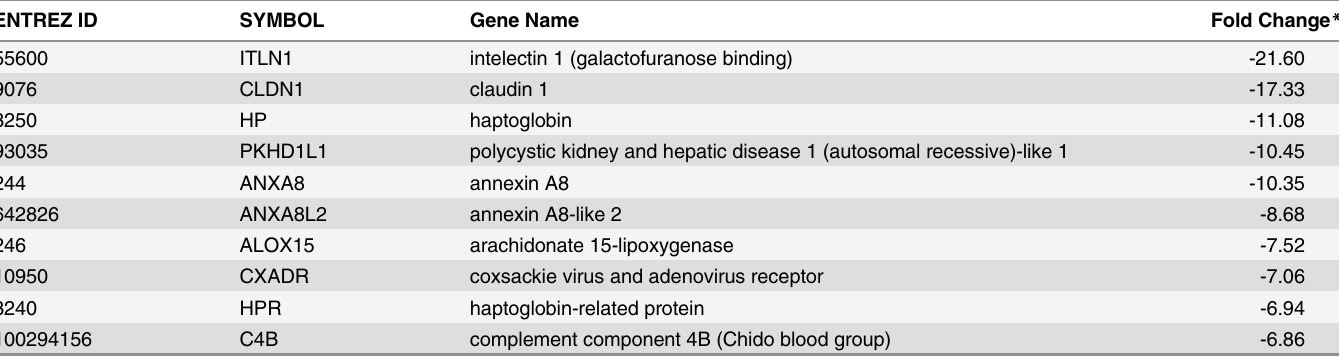
( * ) The fold change represents the number of times the average expression in one group is higher than the one in the other group. Positive values mean higher expression in subcutaneous compared to visceral tissues, while negative values represent higher expression in visceral compared to subcutaneous tissues. Genes are ranked by absolute fold change. All q-values <